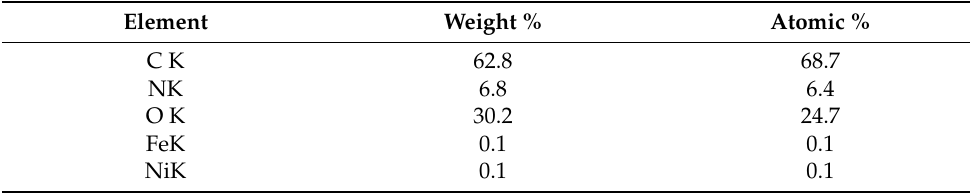
Table 1. Elemental composition of the forestry ligno-ellulosic waste. Element Weight % Atomic